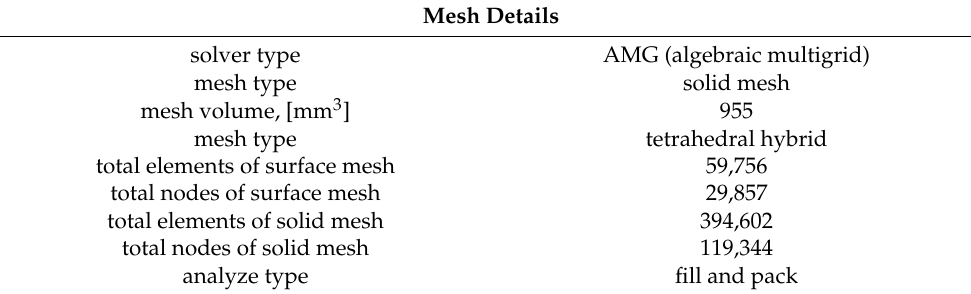
Table 3. Discretization details.